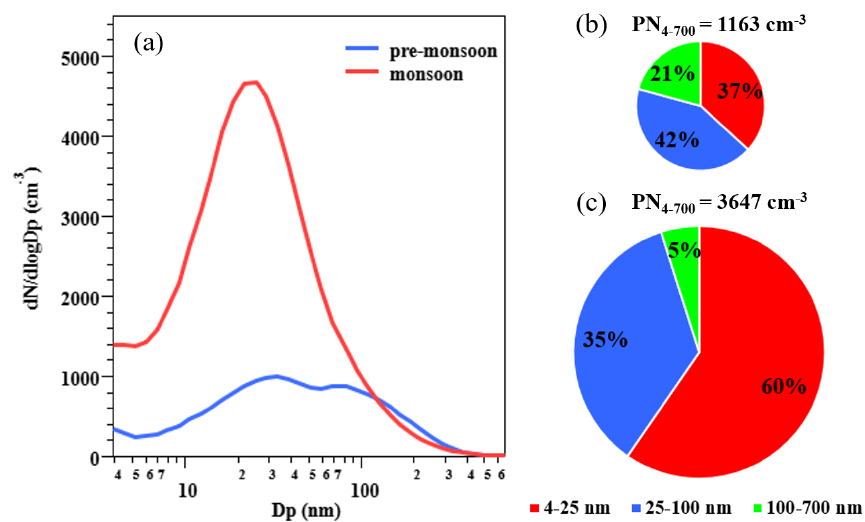
Figure 7. Particle number size distribution (PNSD) at the Nam Co station. (a) Mean PNSD in pre-monsoon and monsoon; the contribution of